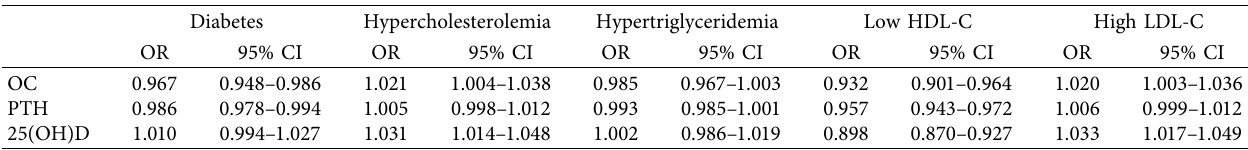
Figure 1: Correlations of parameters of energy metabolism with (A) OC, (B) PTH, and (C) 25(OH)D. FBG, fasting blood glucose; GA, glycated albumin; TC, total cholesterol; TG, triglyceride; HDL-C, high-density lipoprotein cholesterol; LDL-C, low-density lipoprotein cholesterol; OC, osteocalcin; PTH, parathyroid hormone; 25(OH)D, 25-hydroxyvitamin D. Table 3: Odds and 95% CI for diabetes and dyslipidemia.